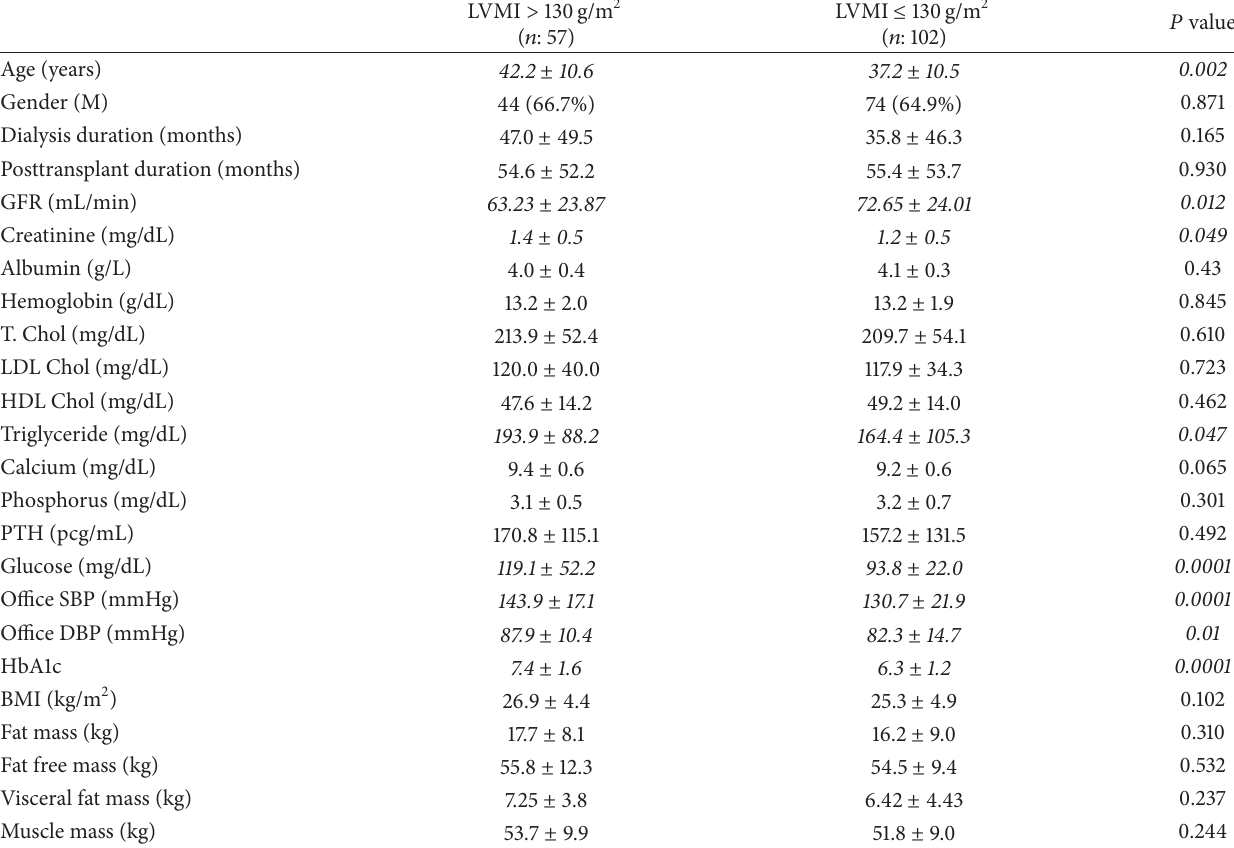
Table 2: The clinical and biochemical parameters of patients according to LVMI groups.